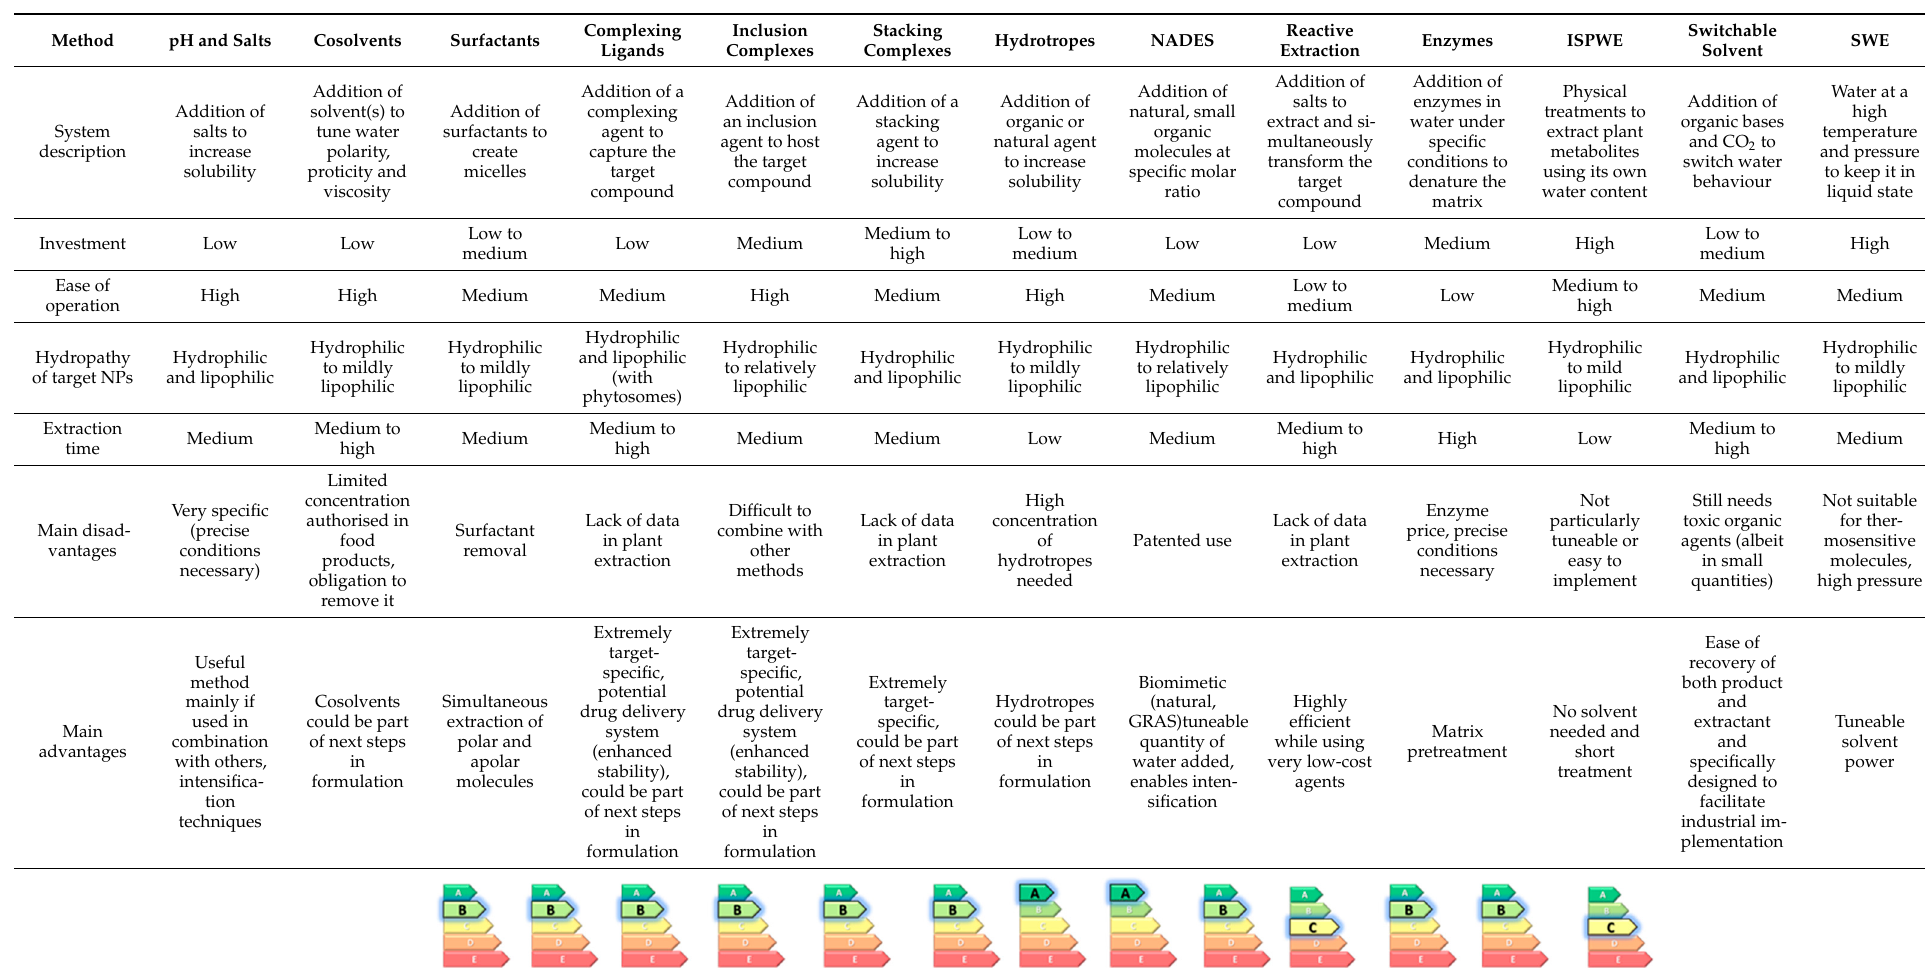
Table 2. Present (from 2000 to 2020): Practical comparison and rating of these